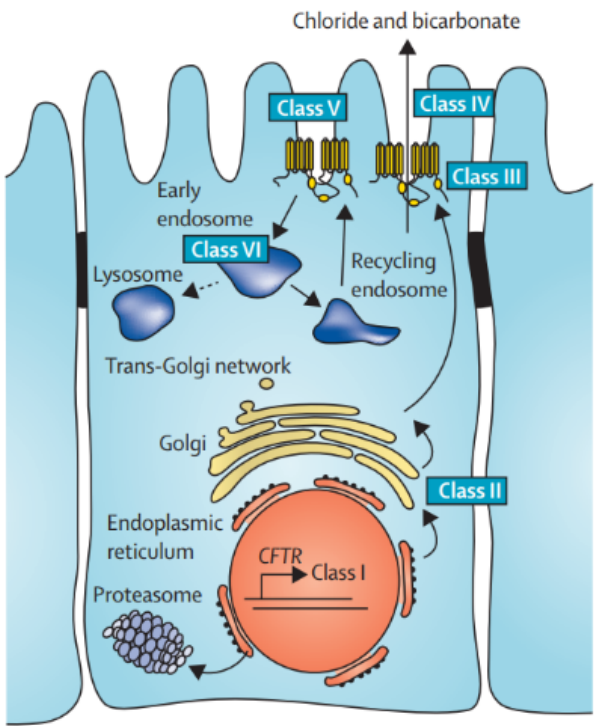
Figure 3. Cystic fibrosis (CF) arises from defective anion channels on epithelial cells, due to CFTR mutations that are grouped into several classes, depending on the cellular process that results impaired. Reproduced with permission from [59]. Copyright Elsevier 2021.